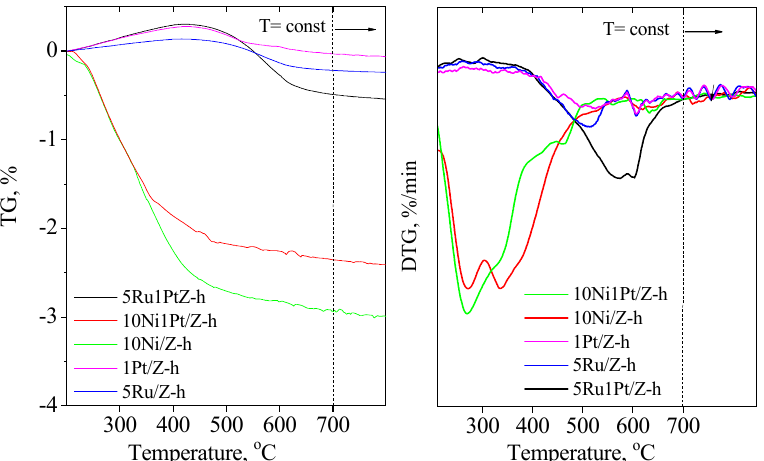
Figure 3. TG curves and TPR profiles of the Ni-, Ru- and Pt-modified hierarchical ZSM-5 zeolites. ATR–FTIR spectra of the studied samples are presented in Figure 4. The broad and intensive peak at 1059 cm − 1 for ZSM-5 and ZSM-5-h was attributed to the asymmetric stretching of SiO 4 [29,30]. The shift of the peak at 1059 cm − 1 to higher wavenumbers was due to the incorporation of metal cations into the zeolite structure or changes in the Al incorporation, which was due to the different Si/Al ratio after treatment with HF and NH 4 F [31]. The shift was more pronounced for the 10Ni1Pt-ZSM-5 catalyst and the peak was detected at 1072 cm − 1 . The stronger interaction of Ni and Pt with the support in the bimetallic catalyst was suggested by TPR experiments and could explain the observed changes in the FTIR spectrum. The shifts were smallest for 10Ni-ZSM-5-h and 5Ru-ZSM-5-h, in which the formation of crystalline metal oxides was detected.